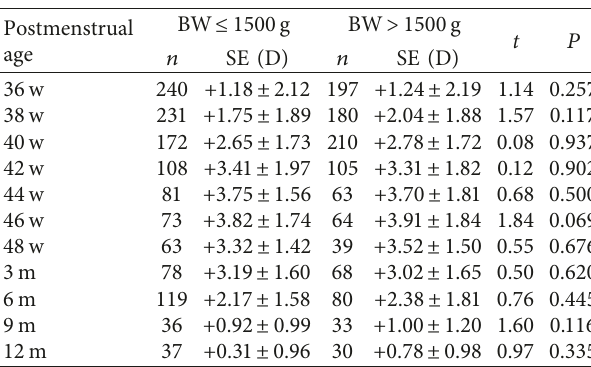
Figure 2: Correlation between SE and gender. SE, spherical equivalent; D, diopter. Table 3: SE of different BW.